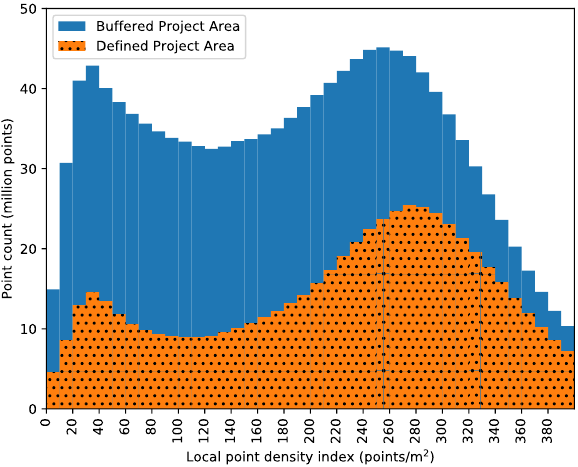
Figure 4. Histogram of local point density index is always lower than those computed by conventional 2D ap- proaches because the area of a 3D inclined surface is always larger than the corresponding 2D projection of the area on the ground. The majority of points contributing to the second peak (around 30 points/m 2 ) are those captured on building facades and other vertical surfaces. The density histogram is an ef- fective means to provide insight into the detailed point dens- ity distribution. For example, the River Liffey is clearly visible in Figure 3a as points captured on water surfaces are sparse due also clearly stand out in yellow due to their high point